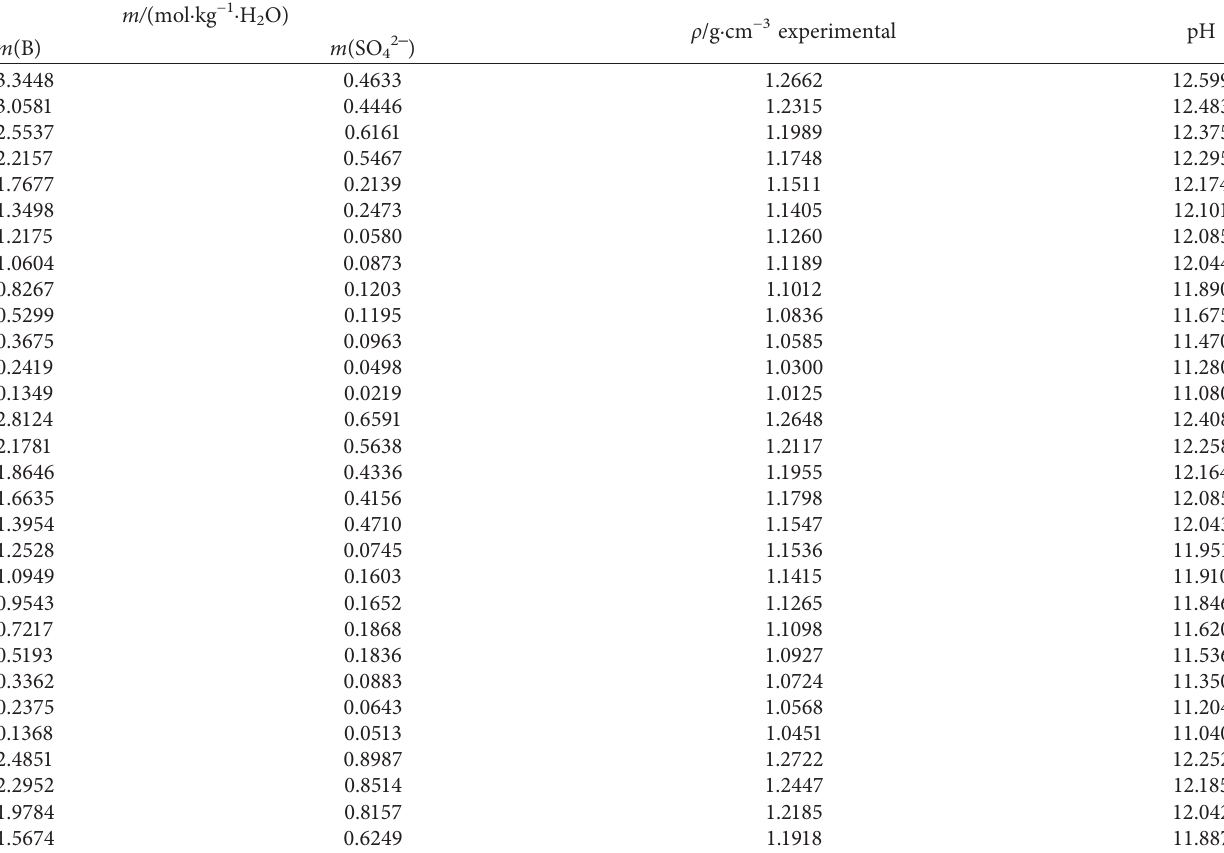
Figure 1: The concentration in the system Na 2 SO 4 –NaBO 2 –H 2 O at different temperatures. Black dotted line, 298.15K [13]; brown dotted line, 323.15K [14]. This work: black solid line, m (Na 2 SO 4 ): m (NaB(OH) 4 ) � 1 :8; red solid line, m (Na 2 SO 4 ): m (NaB(OH) 4 ) � 1 :4; blue solid line, m (Na 2 SO 4 ): m (NaB(OH) 4 ) � 3:8; green solid line, m (Na 2 SO 4 ): m (NaB(OH) 4 ) � 1:2. Table 2: Density and pH values in the system NaBO 2 –Na 2 SO 4 –H 2 O at